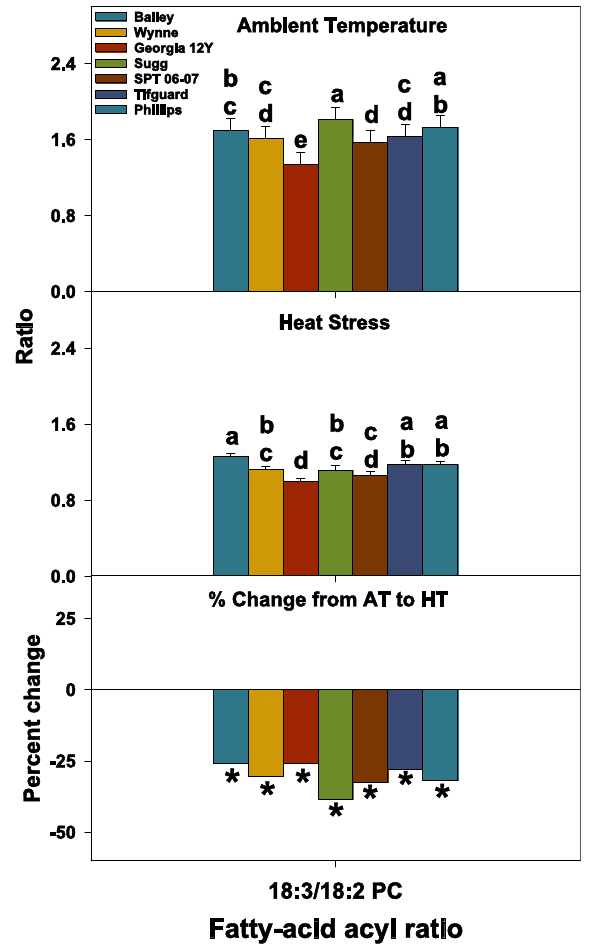
Figure 8. Changes in 18:3/18:2 phosphatidylcholine (PC) lipid ratio in peanut anthers in response to heat stress. Values shown are least-squares means. Error bars represent standard errors about the least-squares mean of 16 observations (2 years × 2 blocks × 4 replications) except for Sugg and SPT 06–07, which have 8 observations (1 year × 2 blocks × 4 replications). Least-squares means with different letters are significantly different according to Fisher’s least significant difference (LSD) test at α = 0.05. An asterisk (*) above bars indicate a significant difference at α = 0.05 between AT and HT for that genotype. AT, ambient temperature (31/22 °C for 2018 and 28/22 °C for 2019; average day/night temperatures during the 17-days and 18-days treatment periods in 2018 and 2019, respectively); HT, high temperature (41/27 °C for 2018 and 38/26 °C for 2019). Data from 2 years (2018 and 2019) were pooled together for analysis. Lipid molecular species are identified as total acyl carbons: total double